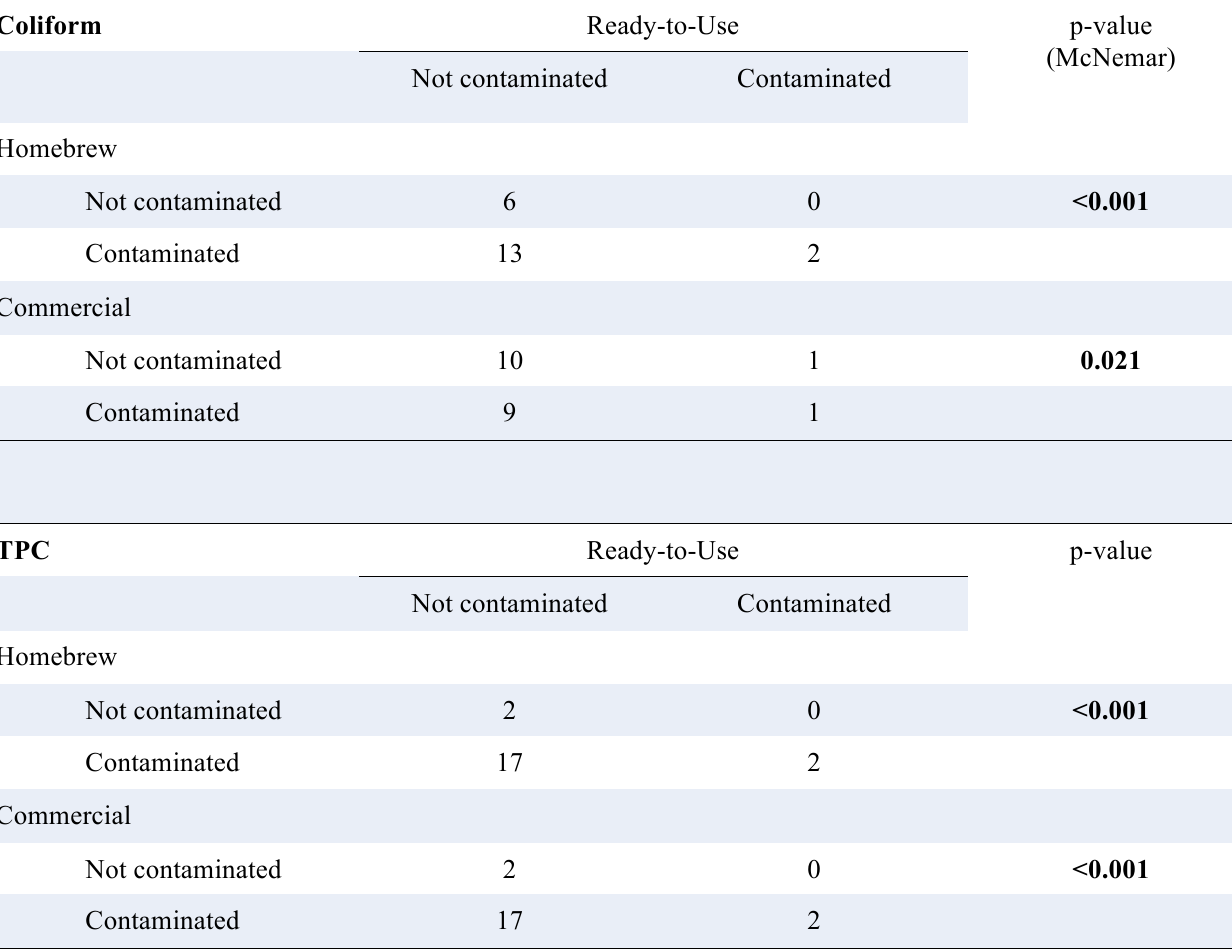
Table 3 Proportion of microbial contamination of different enteral preparation